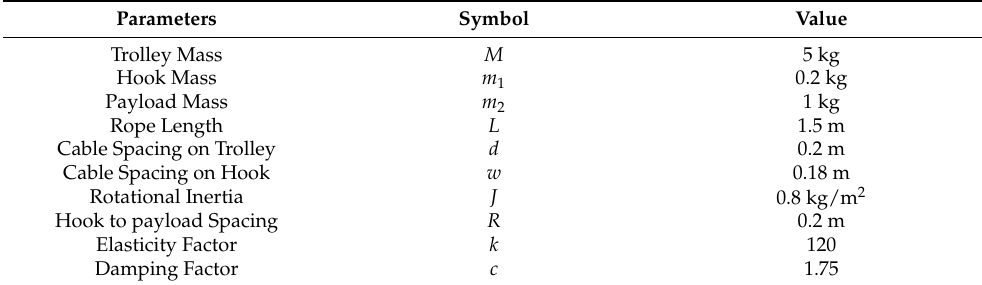
Table 1. Crane system parameters.